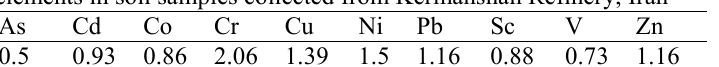
Table 6. Mean values based on pollution factor for potential toxic elements in soil samples collected from Kermanshah Refinery, Iran As Cd Co Cr Cu